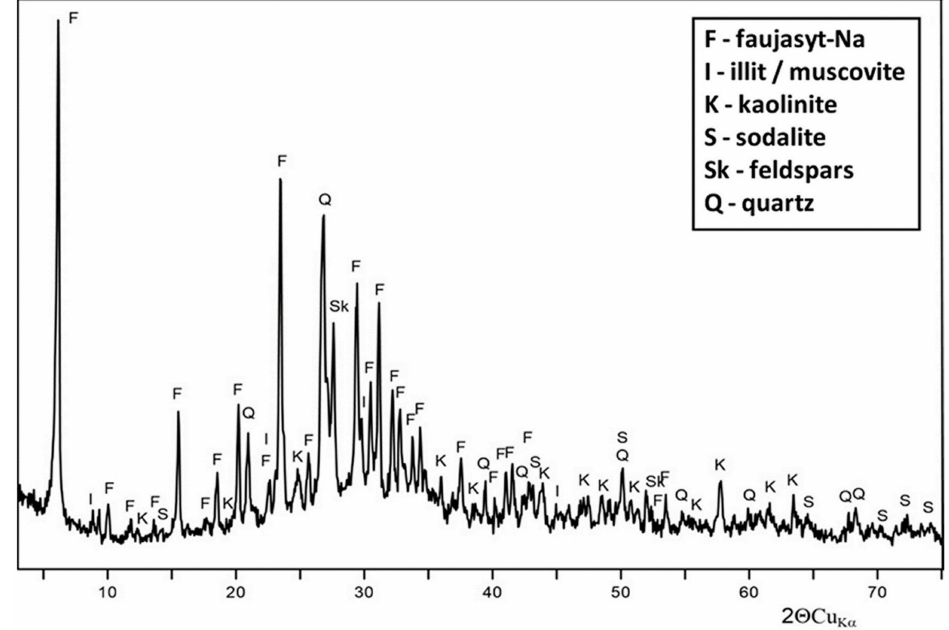
Figure 2. Di ff ractogram of the Filipowice tu ff created in a process of synthesis by fusion method and modified with 0.25 M of Ca(OH) 2 (CaTF).